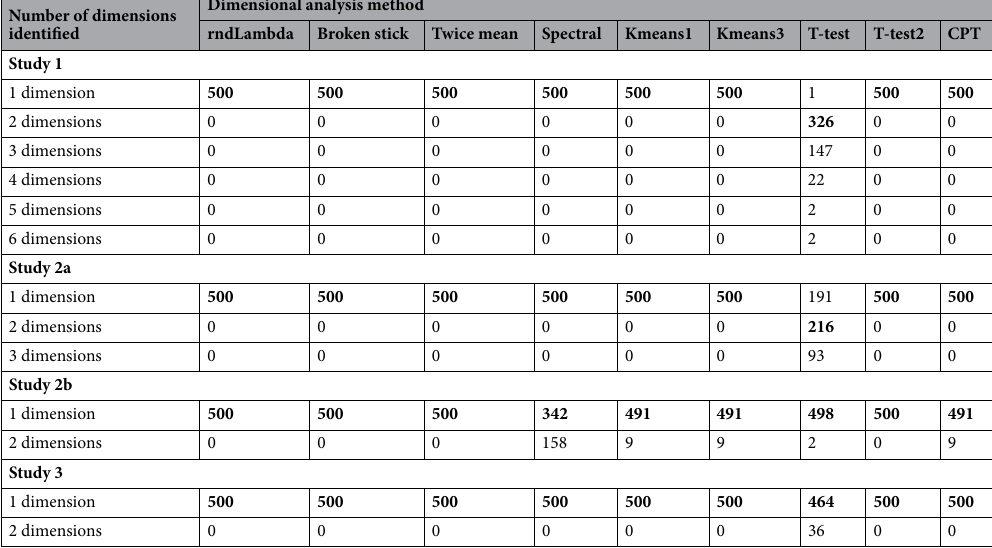
Table 2. Number of principal component dimensions identified by the nine dimensional analysis methods for Studies 1, 2a, 2b, and 3. Each column presents the count of the 500 bootstrapped iterations for a given method that indicated a given number of dimensions. Bold numbers represent the majority of the bootstrapped